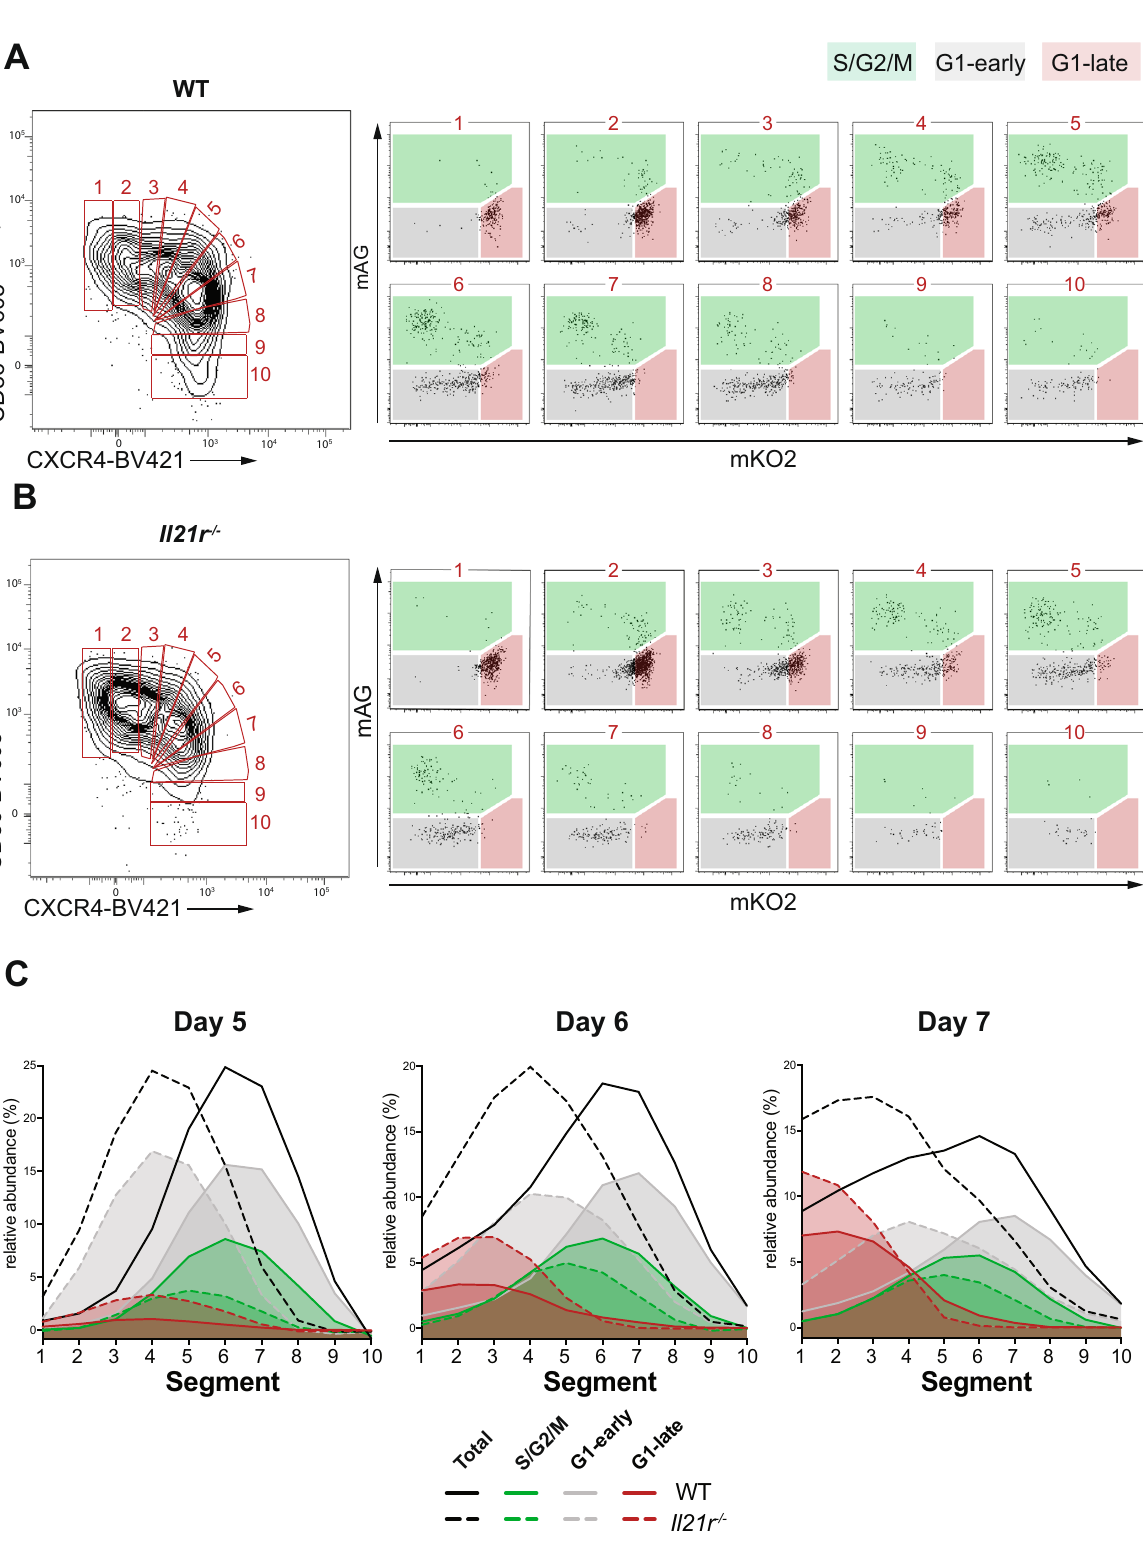
Fig. 3 IL-21 de fi ciency alters cell cycle phase distribution across GC zones. Representative fl ow cytometry pro fi le of day 7 splenic WT ( A ) and Il21r − / − ( B ) NP-binding GC B cells (CD138 − CD19 + NP + CD38 − Fas + ) showing the 10 electronic gates (segments) used to analyze Fucci reporter pro fi le in relation to CXCR4 and CD86 expression (left, large graphs) and the corresponding mKO2 vs mAG pro fi les (right, small graphs) with gates to identify S/G2/M (green shaded), G1-early (gray shaded), and G1-late (red shaded). C Relative abundance of total cells (black lines) and cells in individual cell cycle phases (shaded histograms) among the segments indicated in A and B at days 5, 6, and 7 post immunization. Solid lines indicate WT and dashed lines Il21r − / − . Curves were interpolated using GraphPad Prism 7 and 8. Data represent three independent experiments with 6, 7, or 8 mice per time point per genotype; fi nal gates with ≤ 10 events were excluded. Source data are provided as a Source Data fi